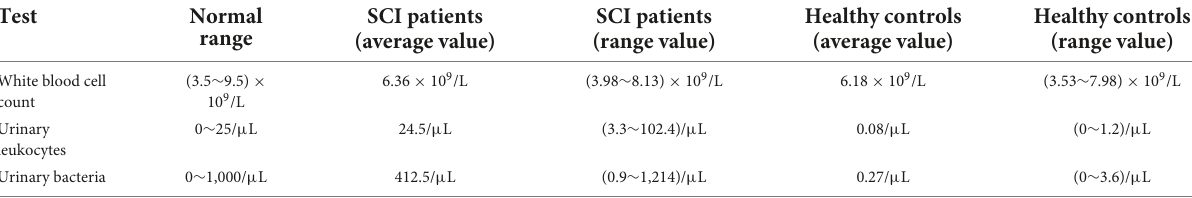
TABLE 2 Blood and urine biochemical parameters of SCI patients ( n = 23) and healthy control ( n = 21).